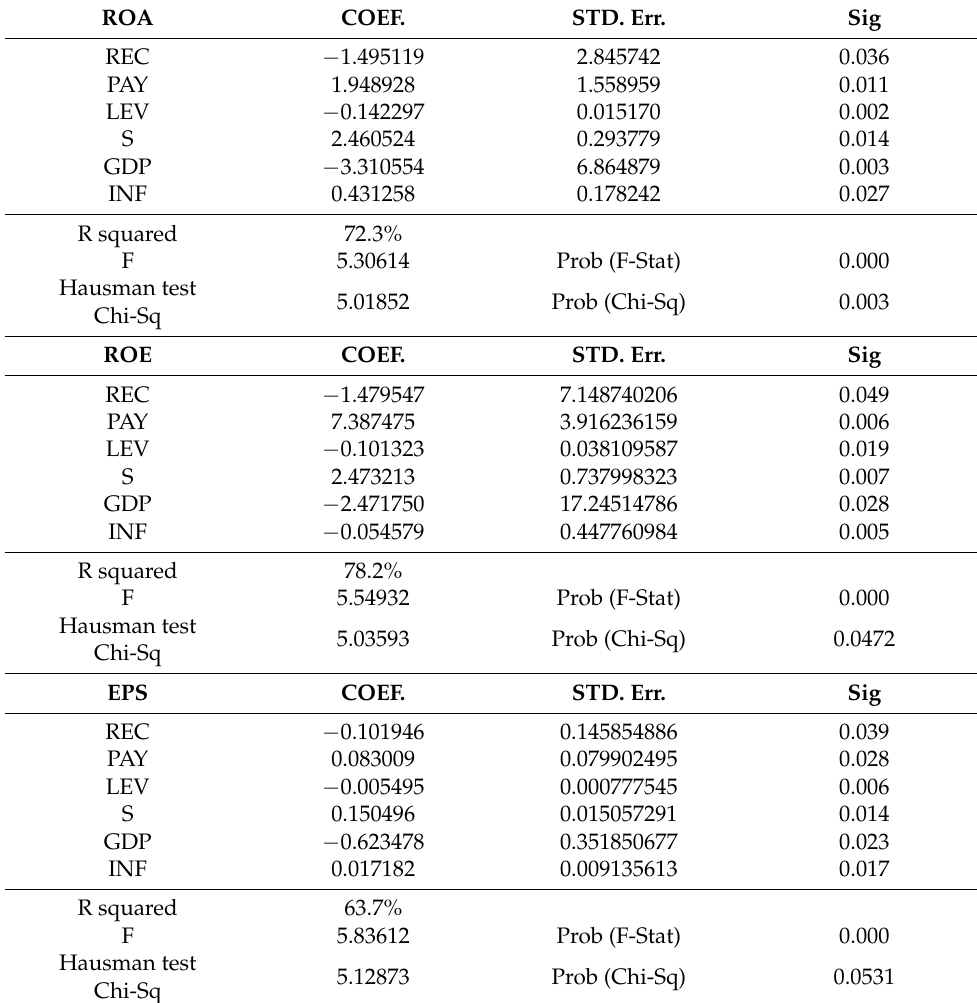
Table 4. Model 1 Fixed Effect Model Results (ROA, ROE, and EPS). ROA COEF. STD.